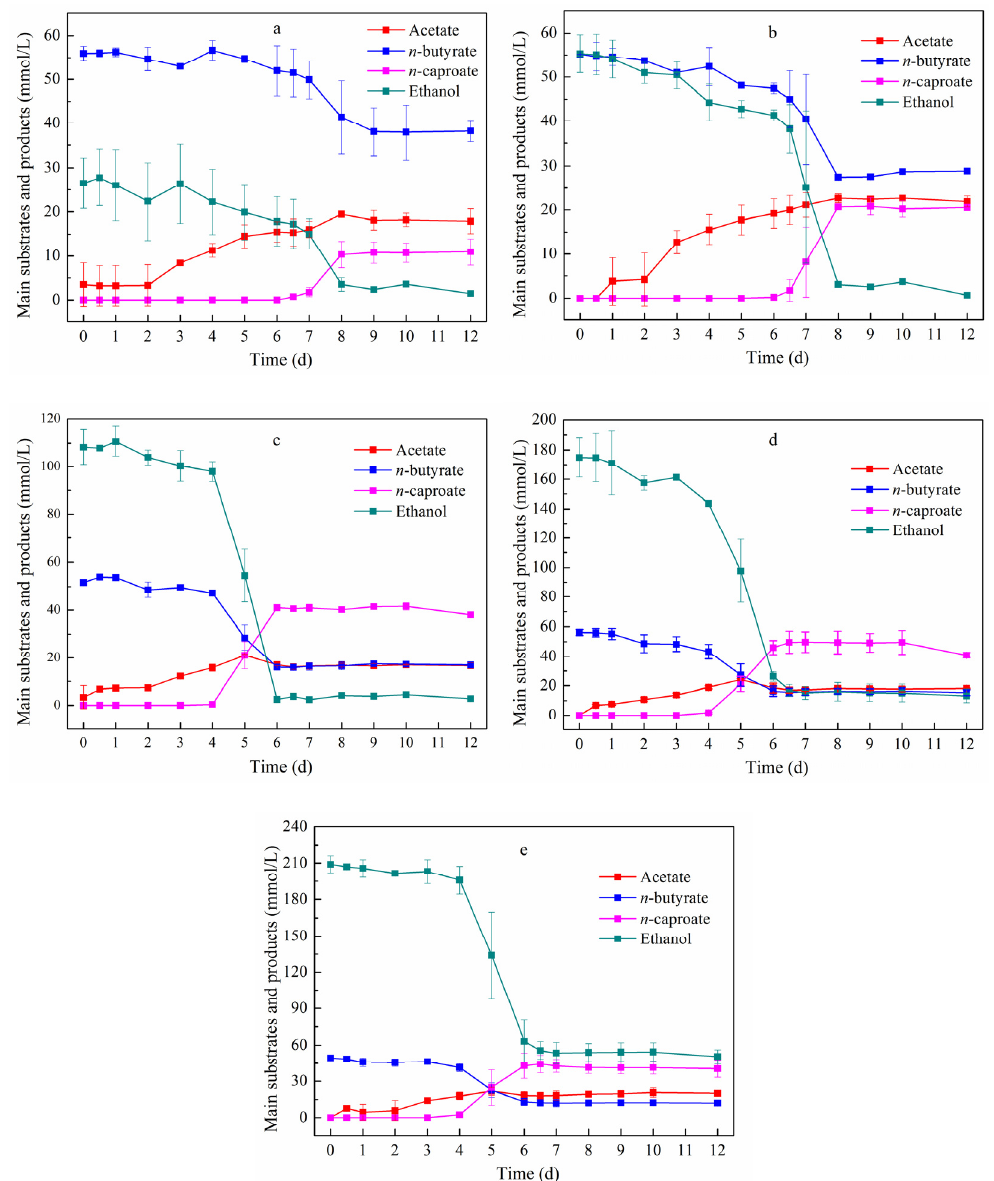
Figure 5. Concentration variation of main substrates and products along chain elongation with n -butyrate/ethanol ratios of 2:1 ( a ), 1:1 ( b ), 1:2 ( c ), 1:3 ( d ), and 1:4 ( e